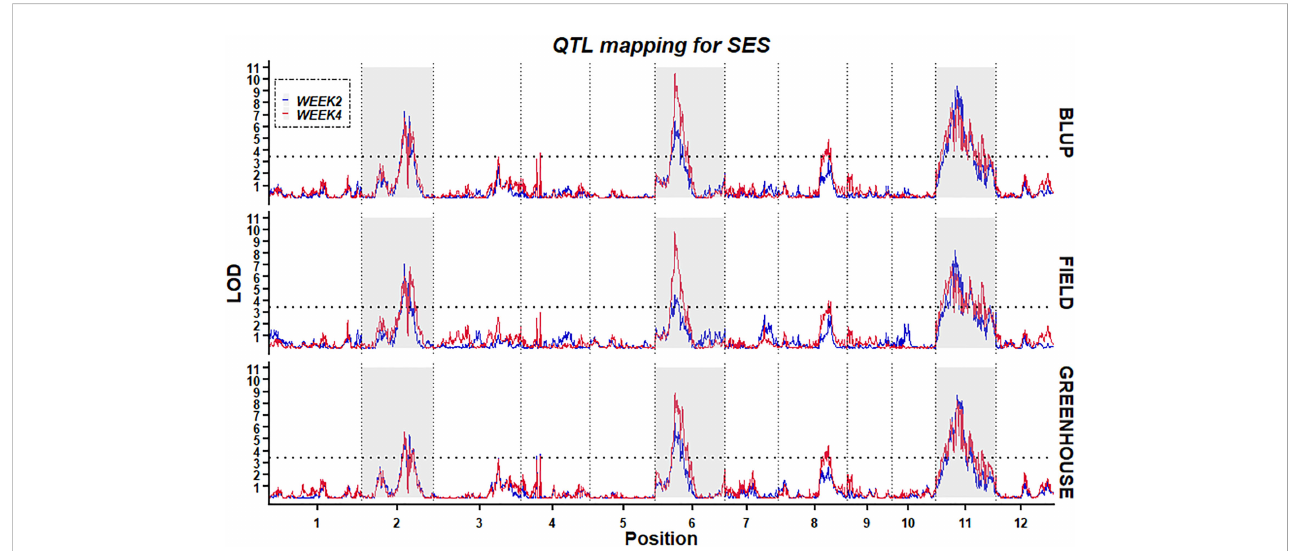
FIGURE 6 Stability of QTL mapping. The x-axis scales genetic distance on chromosomes, while the y-axis represents the LOD scores of W2SES and W4SES.